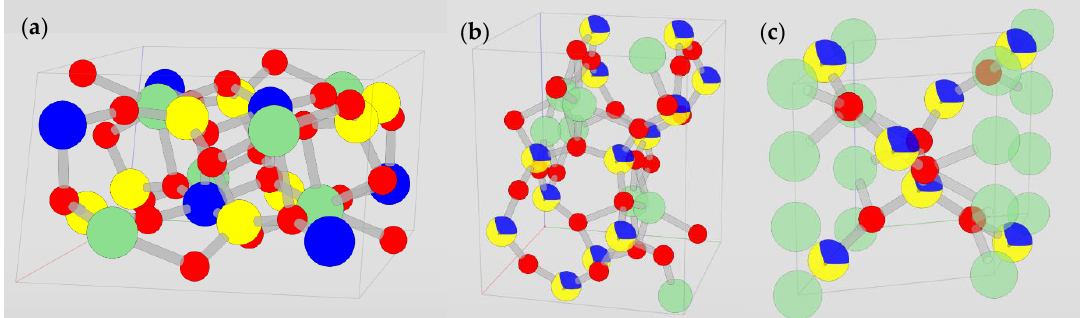
Table 2. Crystallographic data of the different spodumene structures [34,38,39].